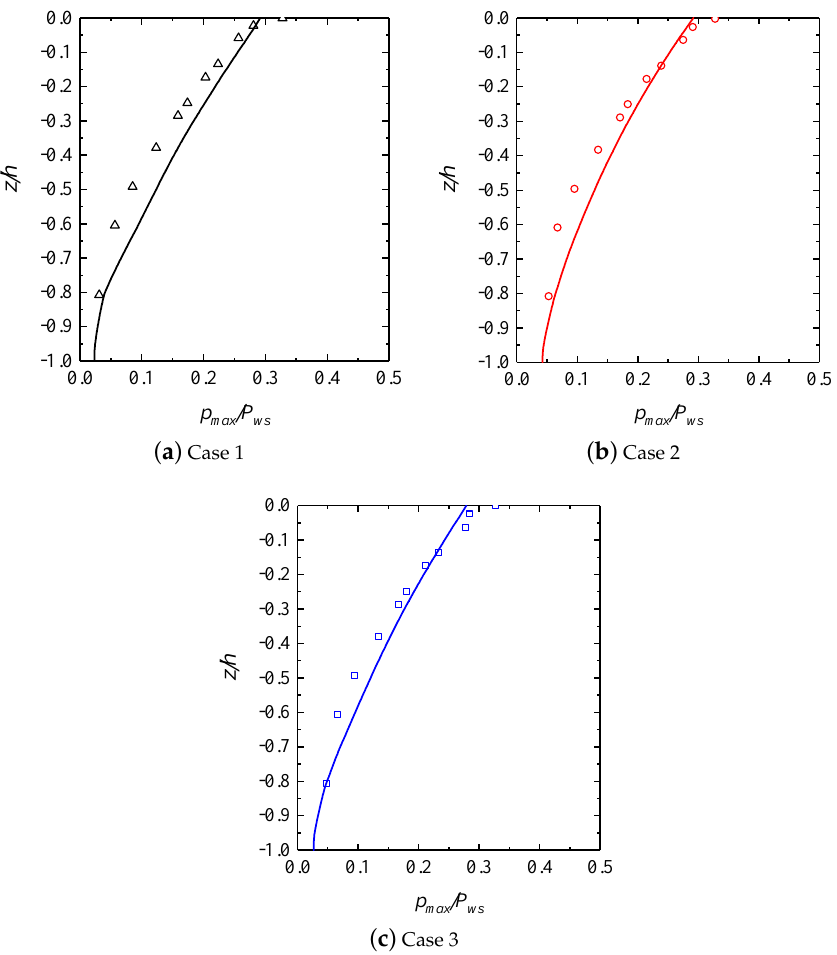
Figure 9. Comparisons between numerical and experimental solutions of wave-induced pore pressure in a non-homogeneous